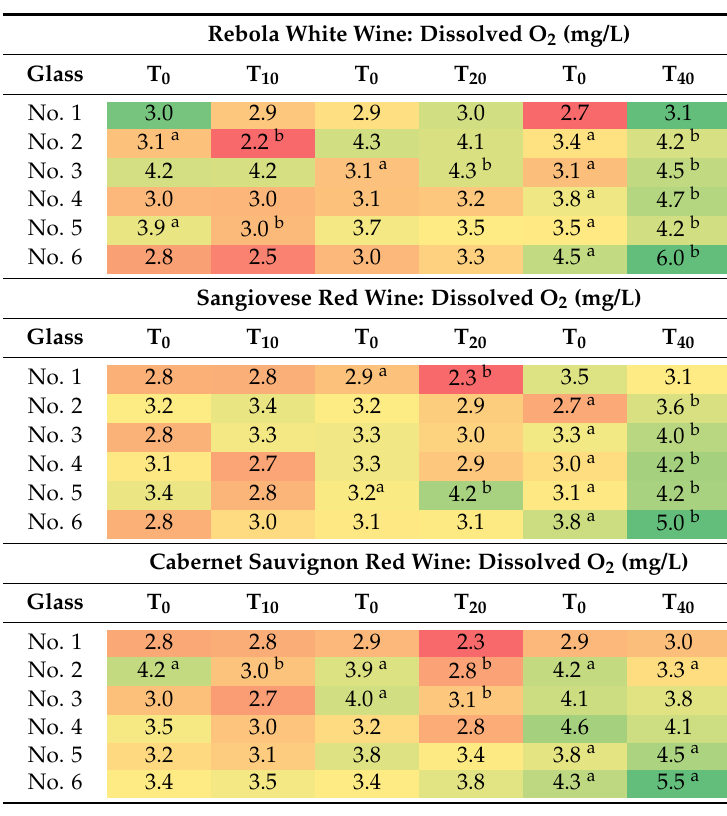
Table 2. Heatmap plot of dissolved oxygen (mg/L) in wine glasses at time zero (T 0 ) and after 10, 20 and 40 s (T 10 , T 20 , T 40 ). Legend: glass 1–6 refers to different shape (see Table 1 for details). The symbol in letters (a, b) refers to significant paired difference between samples ( p -level = 0.05) if occurred.